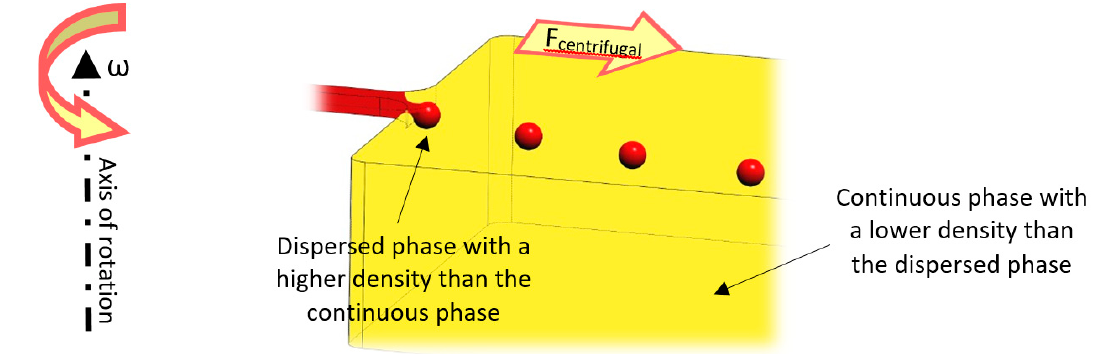
Figure 2. A schematic view of the step emulsification method.